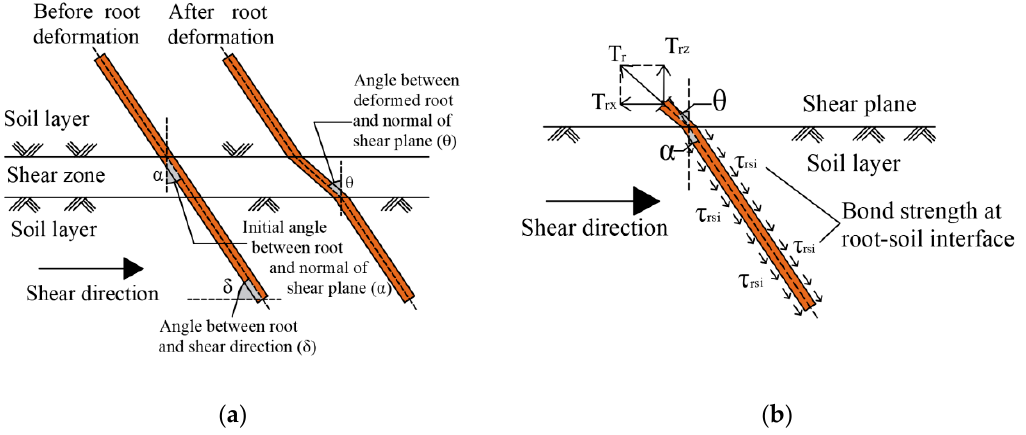
Figure 16. Schematic diagram of a mechanical reinforcement model of soil by root based on interface bonding ( a ) Root deformation in root-bearing soil ( b ) Force analysis of root.